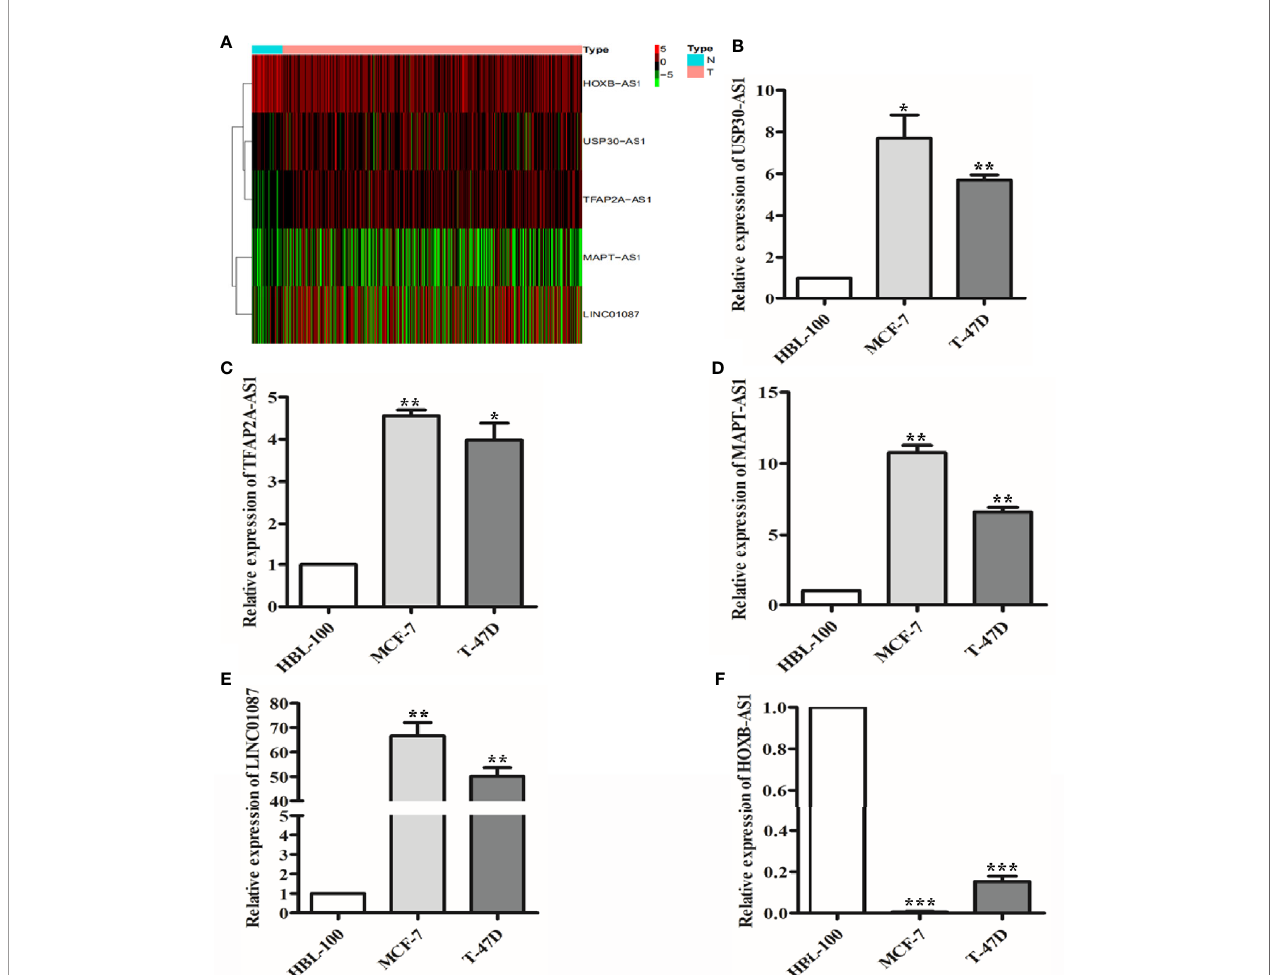
FIGURE 9 | The expression of 9 lncRNAs in breast cancer tissues and cells. (A) Heat map of 5 lncRNAs with signi fi cantly differential expression in breast cancer tissues. (B – E) qRT-PCR results showed that USP30-AS1, TFAP2A-AS1, MAPT-AS1, and LINC01087 expression were higher in breast cancer cell lines than in the normal cell lines. * P <0.05, ** P <0.01 (F) qRT-PCR results showed that HOXB-AS1 expression was lower in breast cancer cell lines than in the normal cell lines. *** P